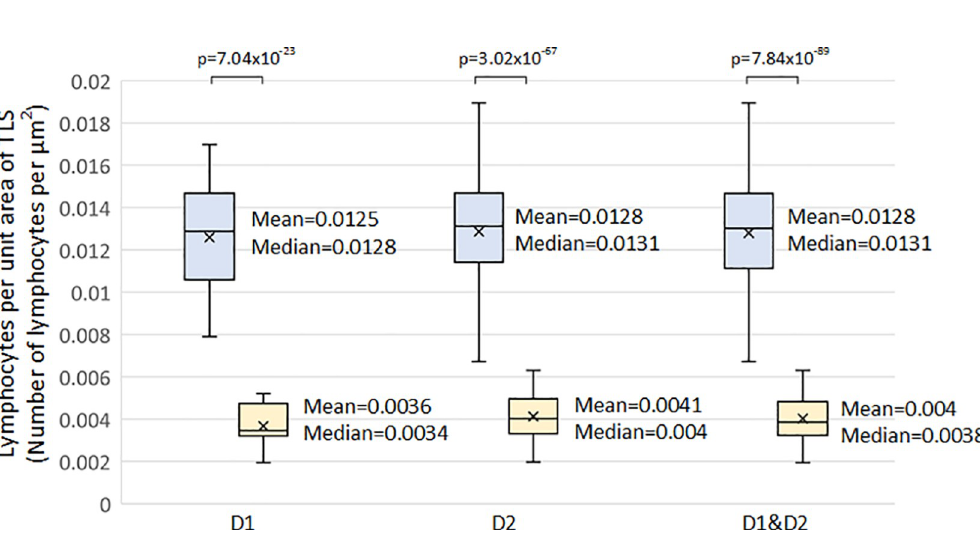
Fig 8. Box plots comparing lymphocyte density between the identified TLS regions and non-TLS regions in hematoxylin and eosin (H&E) stained histological slides included in dataset 1 (D1), in dataset 2 (D2) and in both of them (D1&D2).